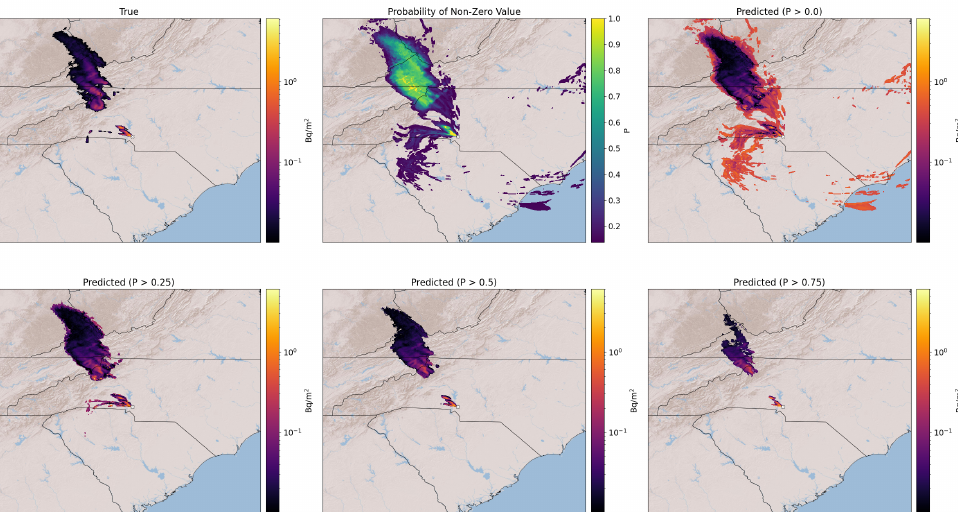
Figure 6. True FLEXPART-WRF output vs. predicted output at several decision threshold values for the elevated release ensemble member 0 with n = 50. The WRF parameterization choices for this ensemble member were PBL 1, LSM 1, CU 1, MP 2, and RA 1. The top middle plot shows the original decision threshold